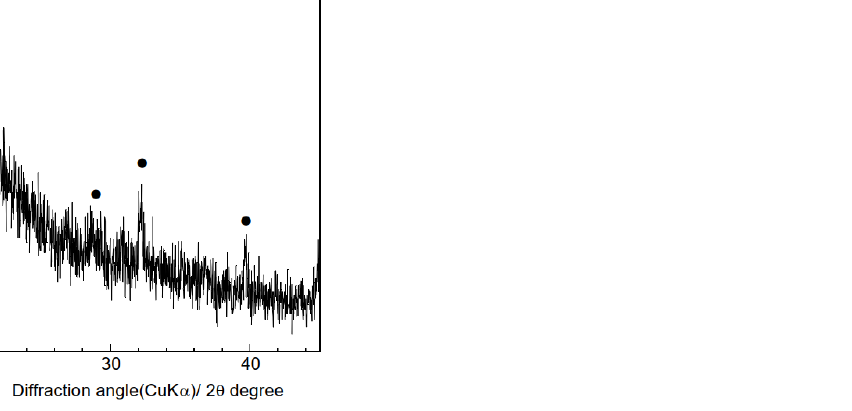
Figure 9. XRD patterns of the composite sample consisting of porous fibers. ( • ) Hydrogarnet.